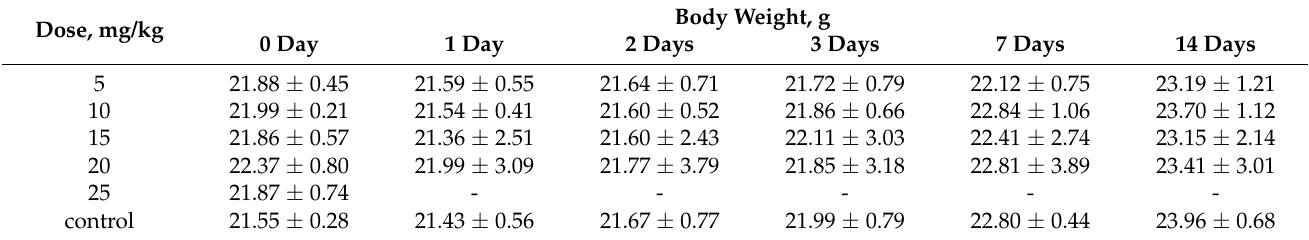
Table 7. Body weight changes of BDF 1 hybrid mice after a single intraperitoneal injection of 4g . Dose, mg/kg